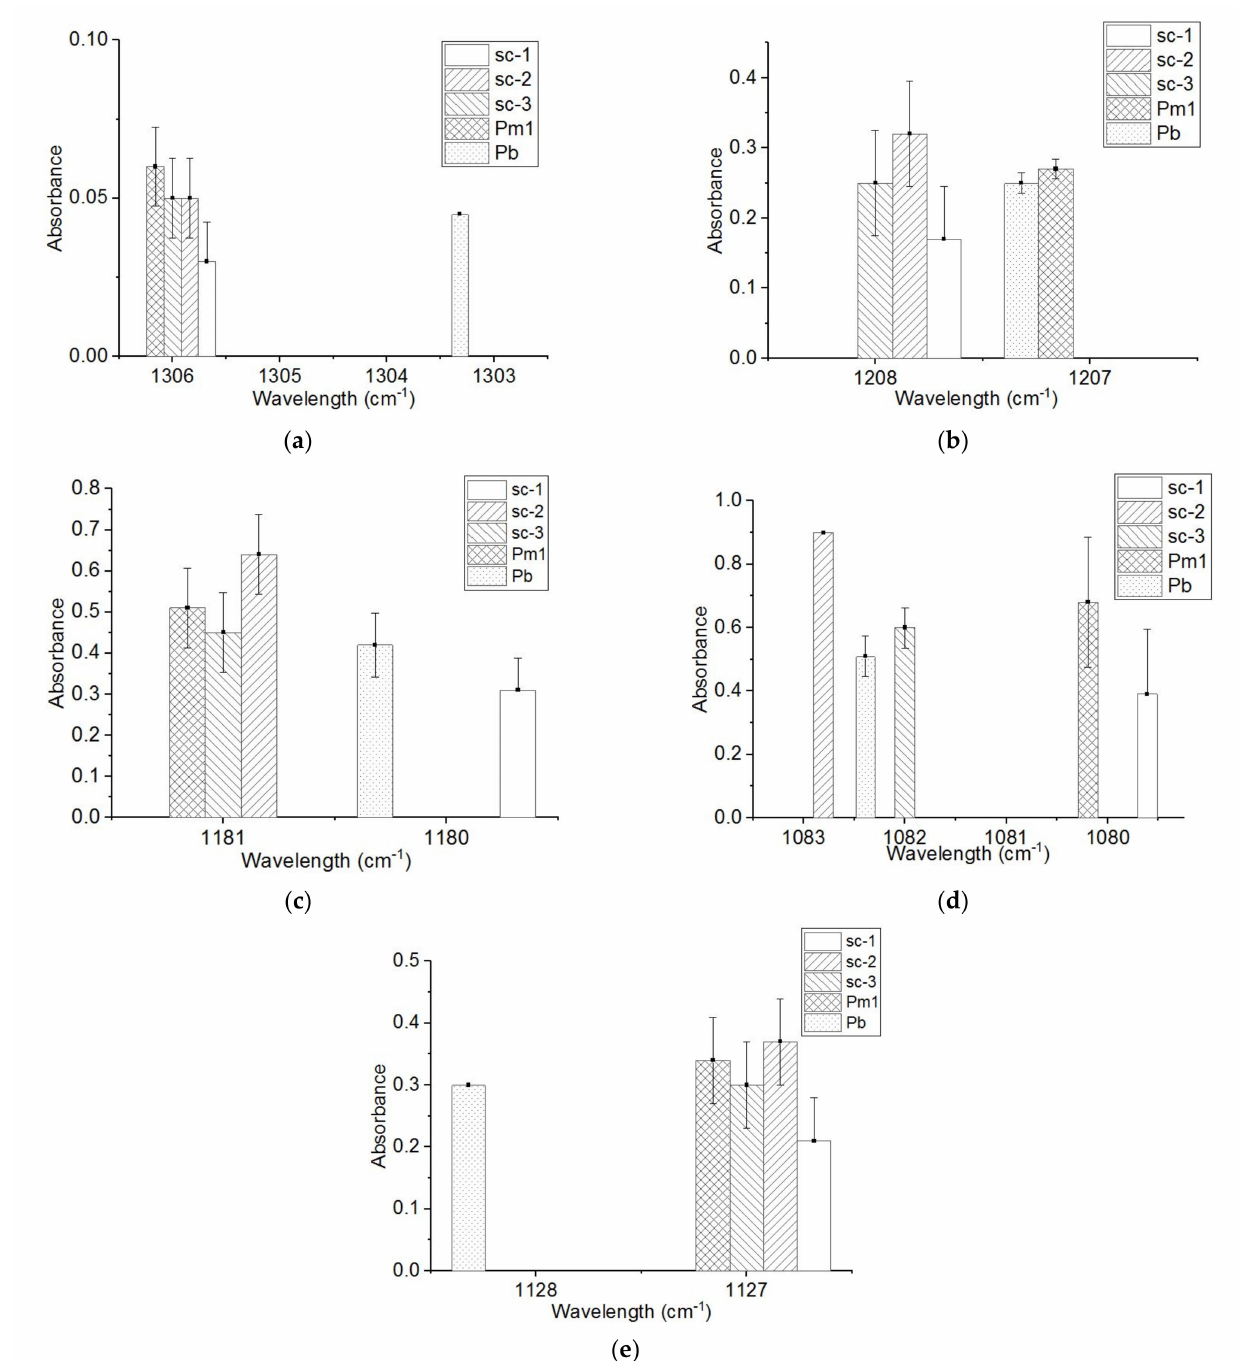
Figure 3. The FTIR absorptions in the 1128 cm − 1 –1306 cm − 1 of the sc-1, sc-2 and sc-3 compounds; base-PLLA (Pb); and stereo-complexer PDLA with medium M w and medium DS (Pm1)). ( a ) 1303–1306 cm − 1 ; ( b ) 120–1208 cm − 1 ; ( c ) 1180–1181 cm − 1 ; ( d ) 1080–1083 cm − 1 ; ( e ) 1127–1128 cm − 1